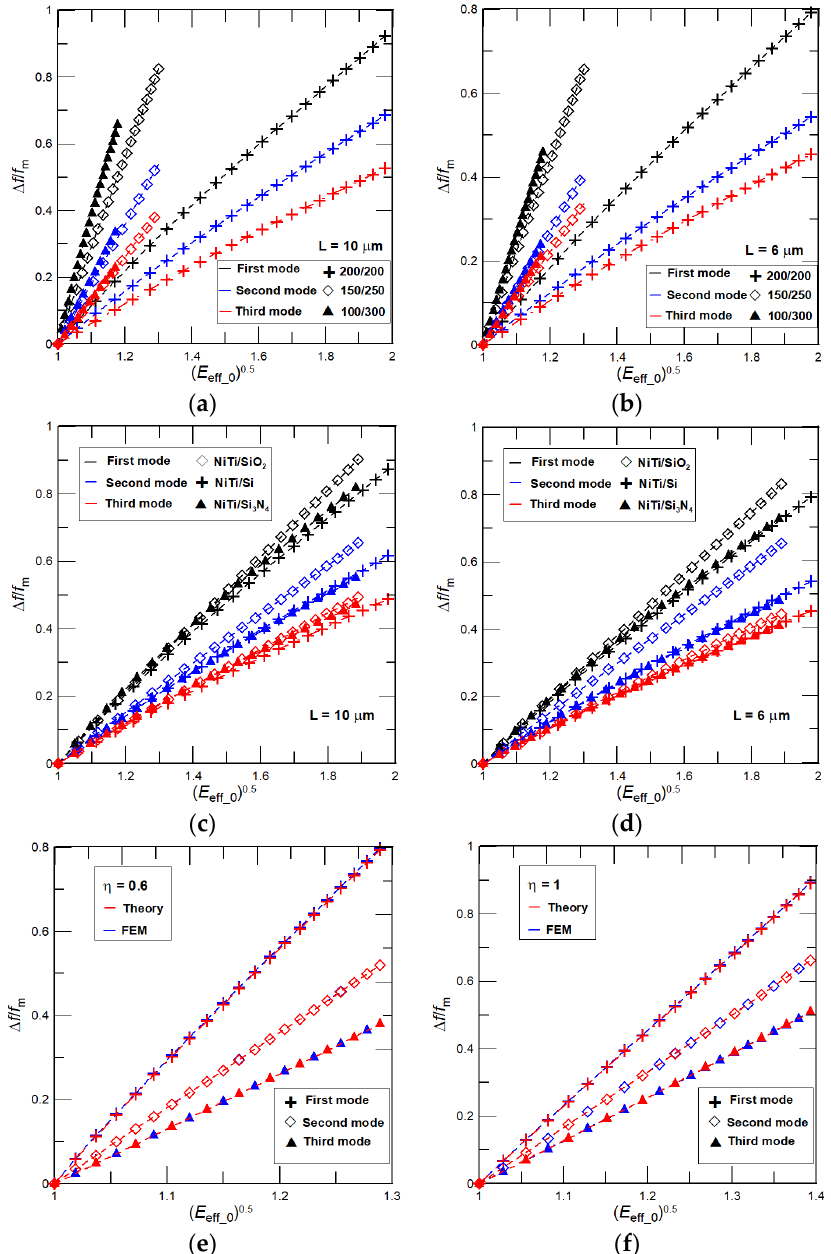
Figure 5. Relative frequency shift Δ f / f m as function of ( E eff_0 ) 0.5 calculated by Equation (11) for NiTi/Si nanocantilevers of η = 0.33, 0.6, and 1, and length ( a ) L = 10 μ m and ( b ) L = 6 μ m. The dependency of Δ f / f m on ( E eff_0 ) 0.5 for NiTi/Si, NiTi/SiO 2 , and NiTi/Si 3 N 4 nanocantilevers of η = 1 and ( c ) L = 10 μ m and ( d ) L = 6 μ m. The dependency of Δ f / f m on ( E eff_0 ) 0.5 obtained by the analytical model and FEM for NiTi/Si nanocantilevers of W = 900 nm, L = 10 μ m and ( e ) η = 0.6 and ( f ) η = 1.